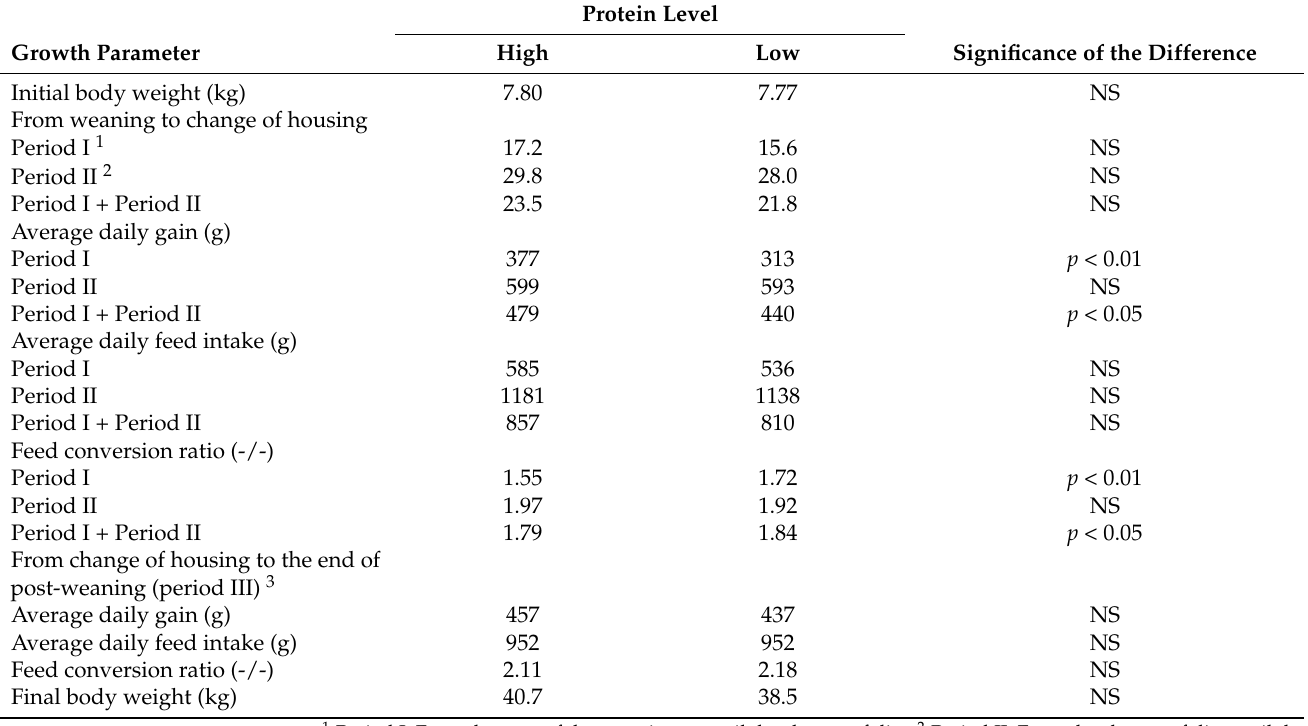
Table 5. Average value of selected growth parameters during the experiment and significance of the difference between high-protein and low-protein diets (n = 6 per treatment).